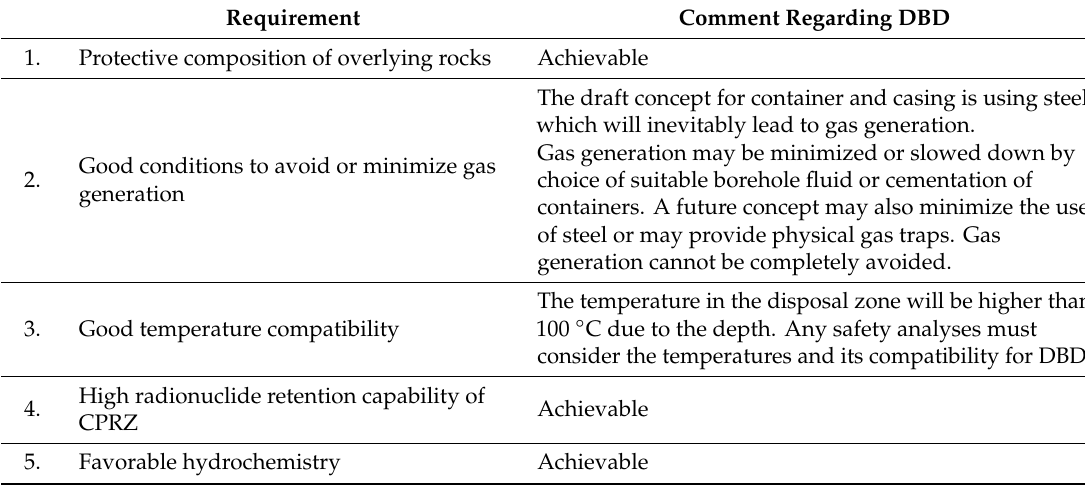
Table 3. Weighting group 3: Further safety relevant